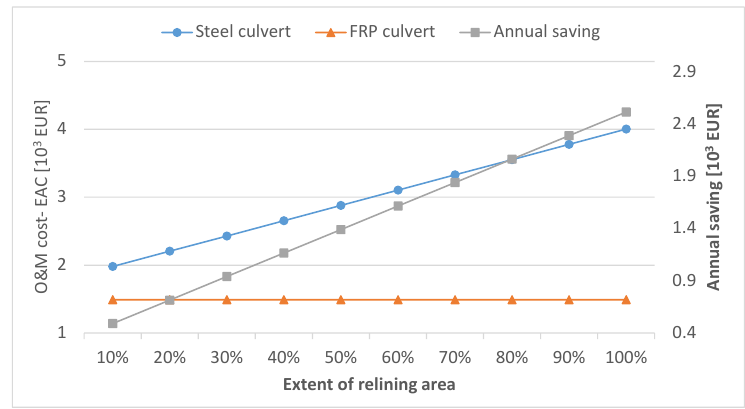
Figure 18. Impact of the extent of shotcrete rehabilitation on the O&M cost and annual saving.